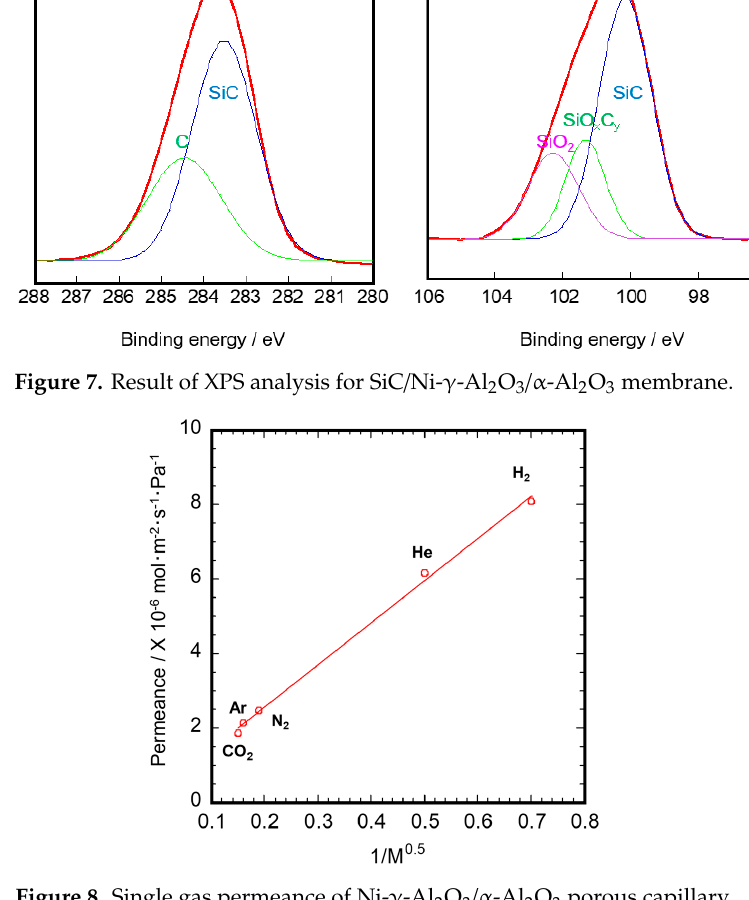
Figure 8. Single gas permeance of Ni- γ -Al 2 O 3 / α -Al 2 O 3 porous capillary.